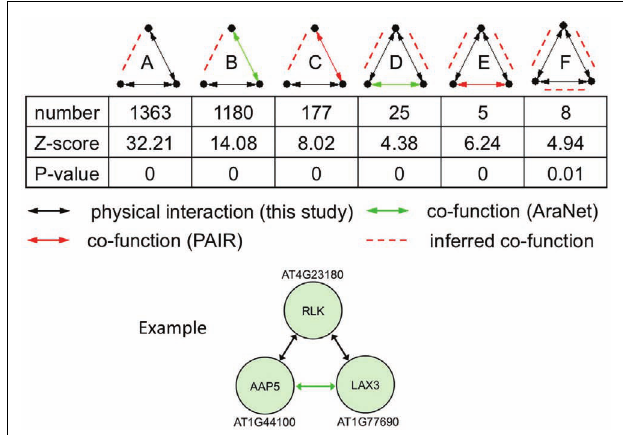
FIGURE 6 | Statistically enriched three-node motifs in the union of the protein interaction (black line),AraNet (Lee et al., 2010; green line), and PAIR DB (Lin et al., 2011; red line) links. Potentially new genetic interactions are shown with red dashed lines.The example motif belongs to class D with two protein interactions and one genetic